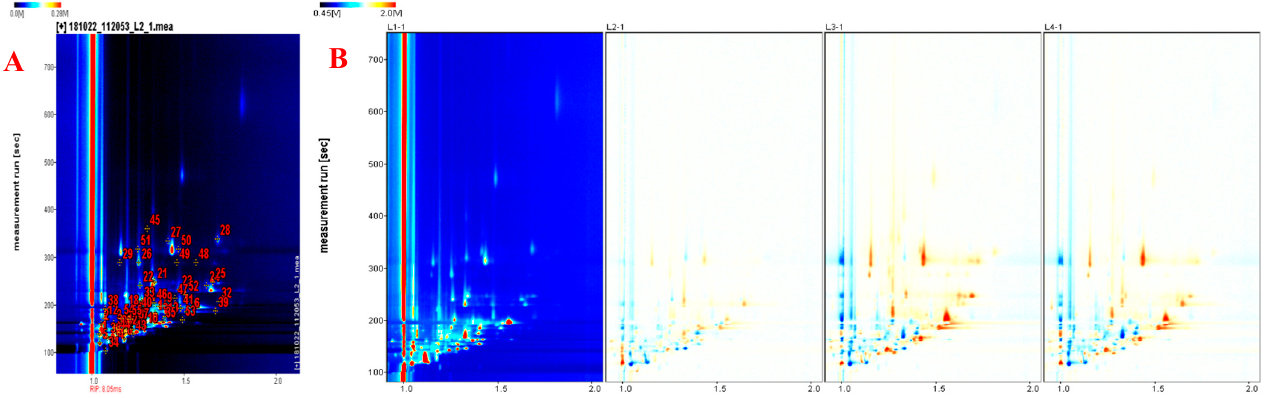
Figure 4. GC-IMS two-dimensional qualitative topographic plot (A) and topographic plot of the four processing stages (B) .